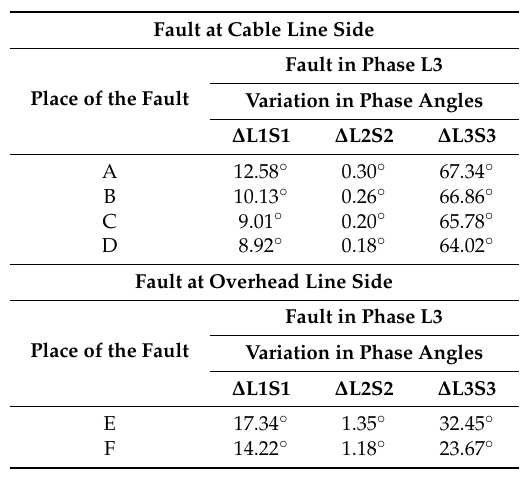
Table 5. Ground fault at overhead and cable line sides in phase L3. Variation in phase angles between currents in the conductors and their respective